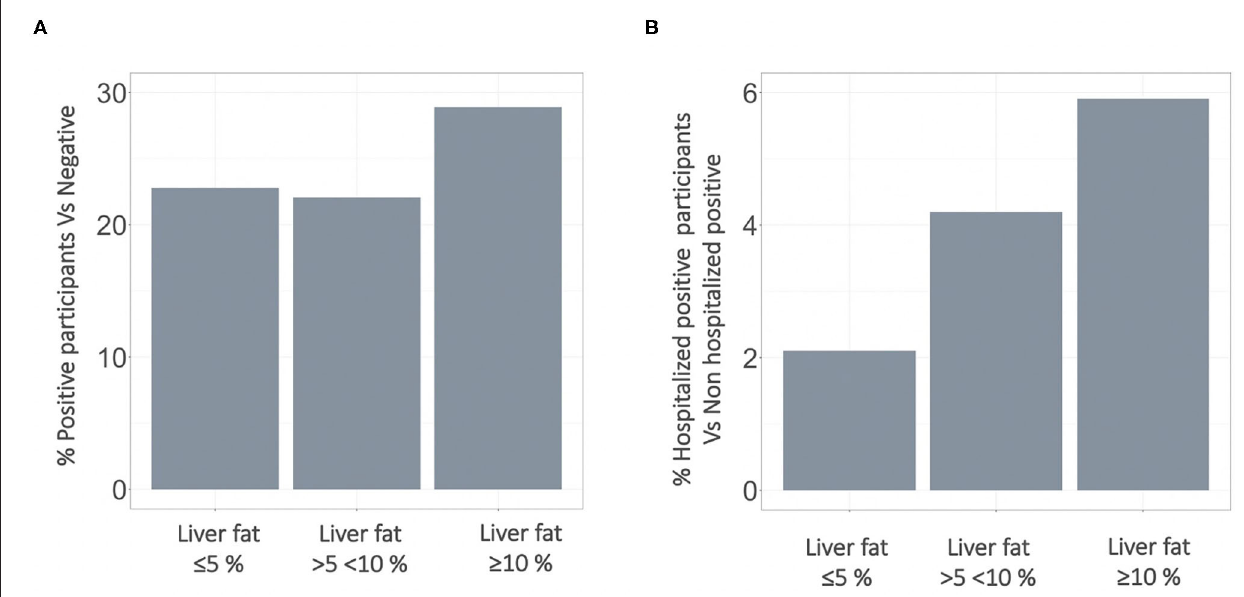
FIGURE 2 | Stepwise increase in percentage of (A) participants testing positive for COVID-19 and (B) being hospitalized with a positive test result. Stratification based on pre-existing fatty liver disease. COVID-19, Coronavirus disease.